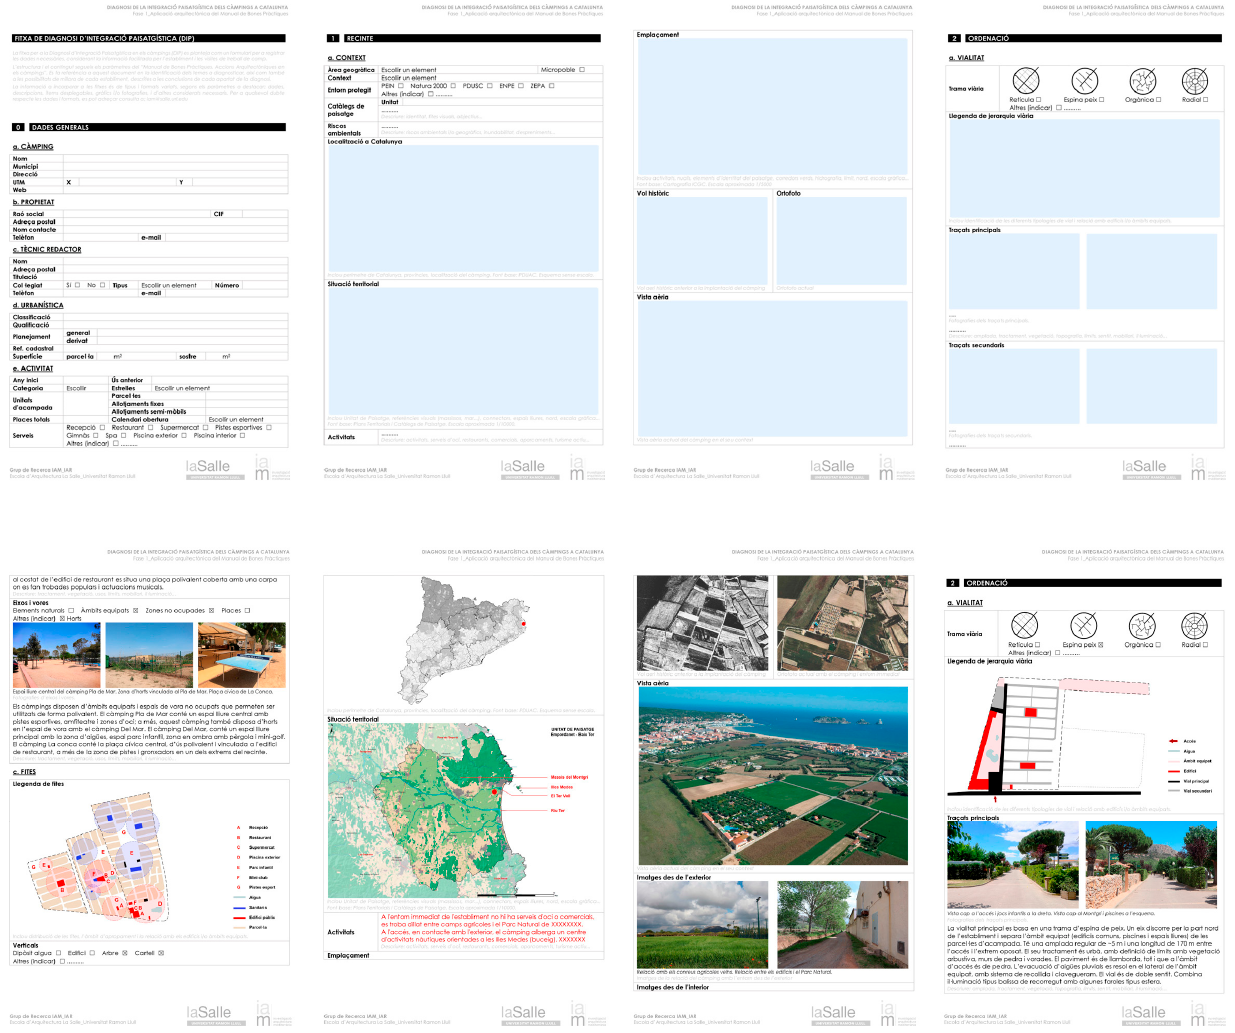
Figure 7. Sample of some pages of the diagnosis sheet: base template in the top row and complete diagnosis report in the bottom row (Source: authors’ own). The complete template is available in the Supplementary Materials (Template